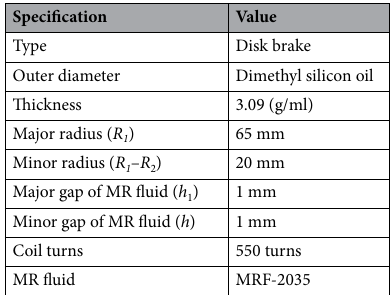
Table 1. Specifications of the proposed MR brake.